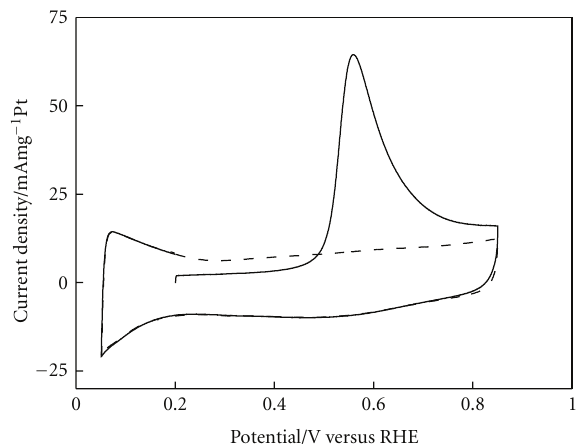
Figure 3: Cyclic voltammograms for CO oxidation at room temperature on commercial catalysts PtRu/C E-TEK. Full line: first scan. Dashed line: second scan. Scan rate: 20mVs − 1 . Supporting electrolyte: 0.5 M H 2 SO 4 . CO adsorption potential: 0.2V versus RHE.